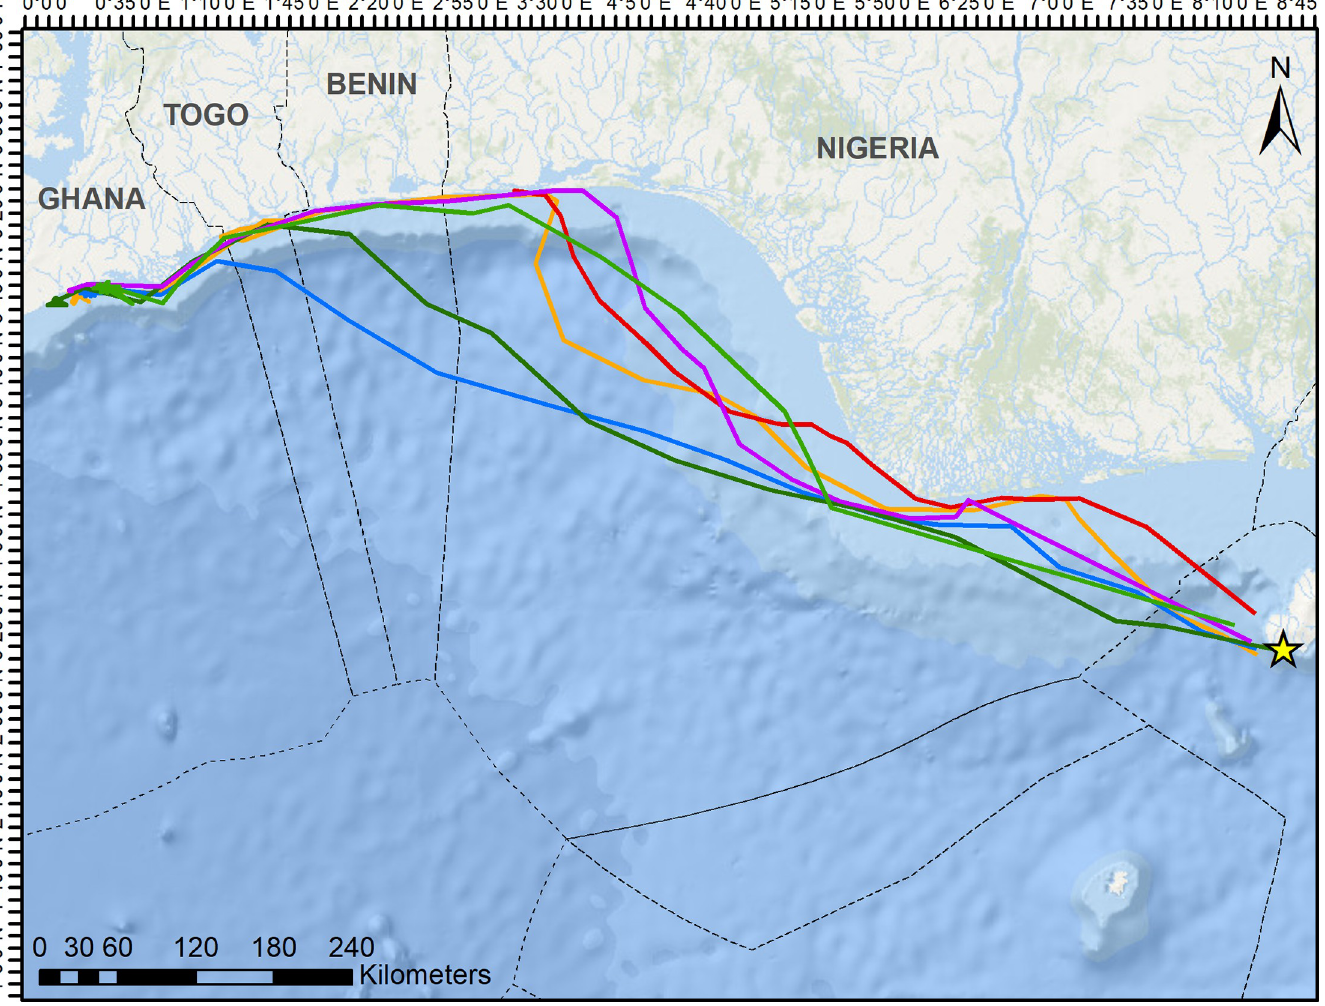
Fig 2. Post-nesting movements of six green turtles (Chelonia mydas) tracked from Bioko Island, after the 2017–18 nesting season. Individuals traveled an average of > 1,000km using a combination of oceanic and coastal migratory routes. Two turtles exhibited oceanic migration routes (blue and dark green tracks); the remaining four turtles remained closer to the continental shelf, migrating more directly across the Bight of Benin, to the coastal waters near Lagos, Nigeria, and then maintained a coastal route. Dotted lines represent the Exclusive Economic Zones (EEZs) of each country. Service layer credits: Esri, Garmin, GEBCO, NOAA NGDC, and other contributors Esri, HERE, Garmin, OpenStreetMap contributors, and the GIS user community.